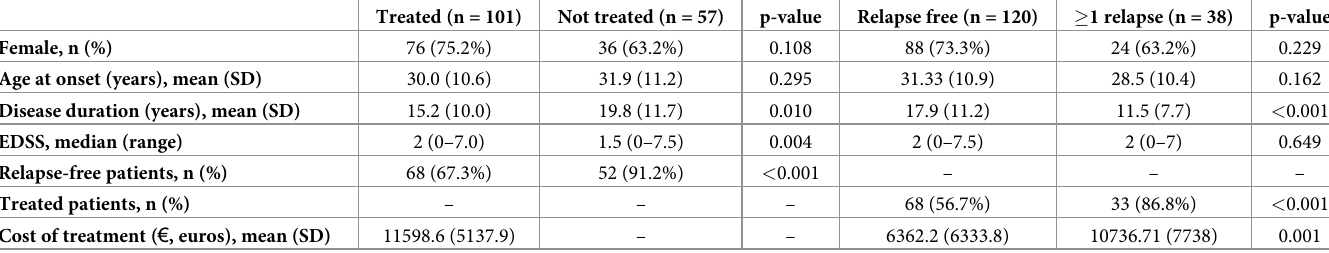
Table 3. Disease characteristics of the 2016 cohort and cost of the DMTs.